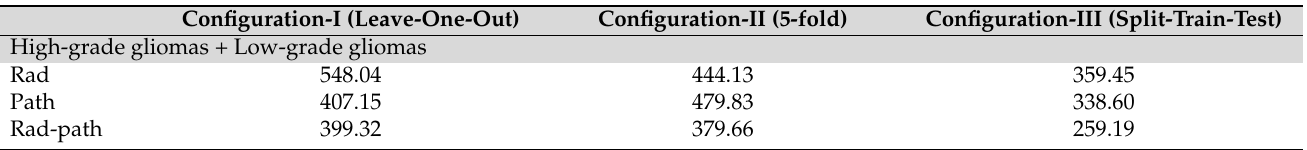
Table 2. Quantitative evaluation of model in terms of mean absolute error (MAE) in predicting survival using rad, path, and rad-path feature sets in leave-one-out cross-validation, 5-fold cross- validation, and split-train-test at 60–40%. The results are separately shown for combined dataset (HGGs + LGGs) and separate cancer grades (HGGs and